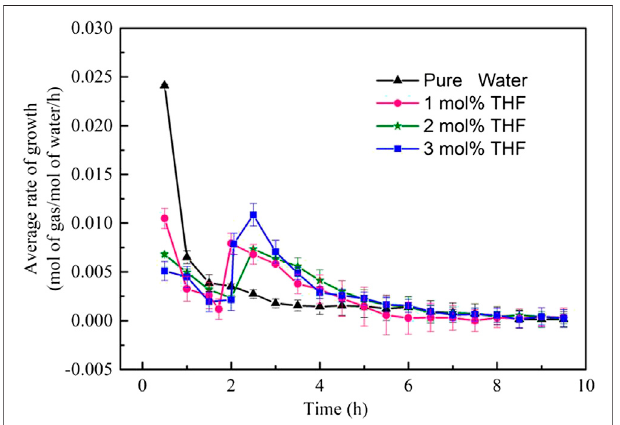
FIGURE 5 | Rate of CO 2 hydrate formation at different initial molar concentrations of THF.